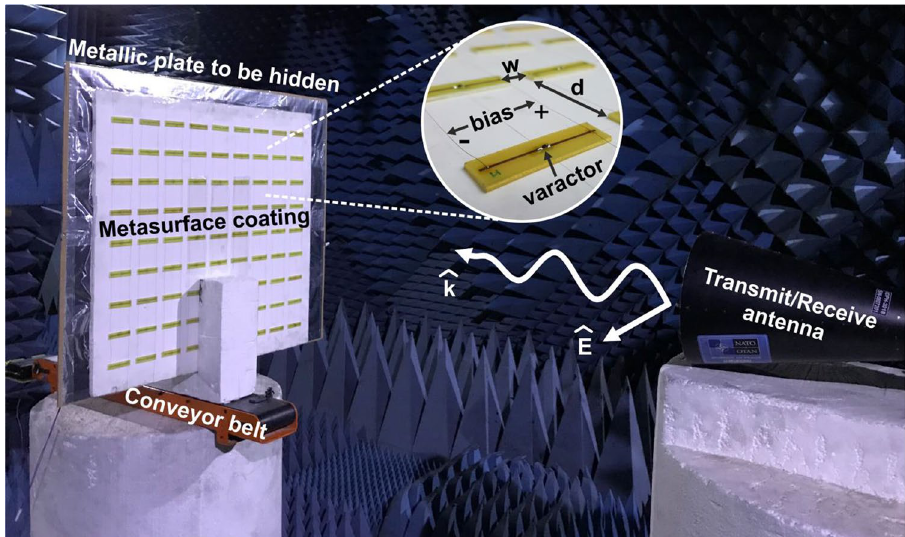
Figure 4. Experimental verification demonstrating the invisibility concept. A metal plate of 0.25 square meters is covered by a metasurface cloak, which is constructed from an array of dipoles with varactors in their gap, allowing temporally modulating its properties. The concealed target can move on the conveyor belt while being observed by the radar